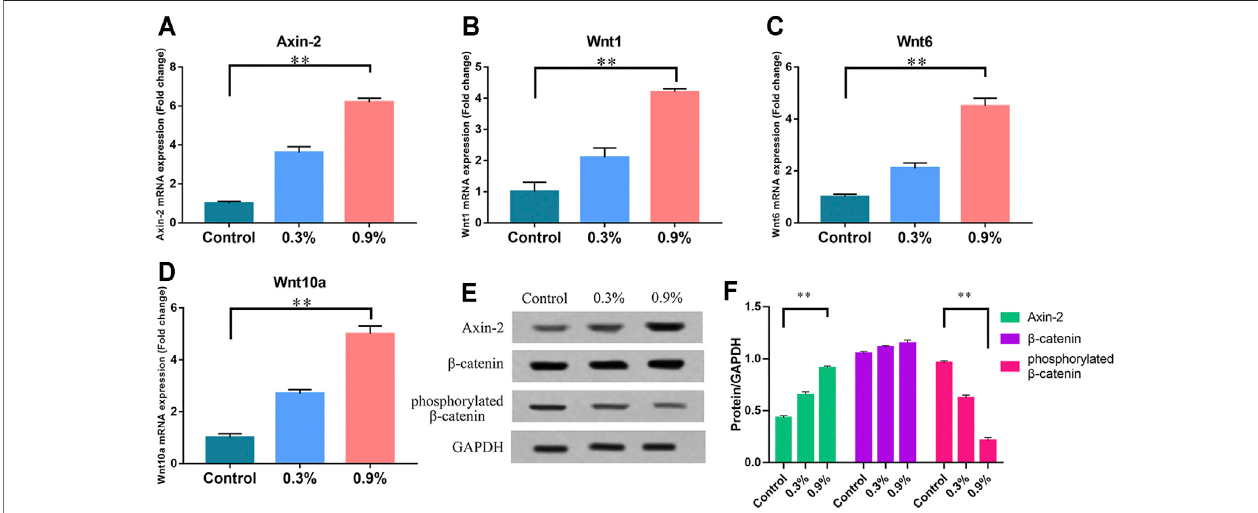
FIGURE3| MechanicalstraincanincreasetheactivityoftheWnt/ β -cateninsignalingpathwayinBMSCs. (A – D) ThemRNAexpressionofAxin-2,Wnt1,Wnt6,and Wnt10a in BMSCs after 7 days of treatment. RT-qPCR data are presented as mean ± SD normalized against the control group data. The housekeeping gene GAPDH wasused asaninternal control. (E) Western blotsofAxin-2,phosphorylated β -catenin, and β -catenin after7 daysoftreatment.GAPDHisshown astheloadingcontrol. (F) Semi-quantitative and statistical analysis of the results in Panel E. Values are plotted as mean ± SD, * p < 0.05, ** p < 0.01.